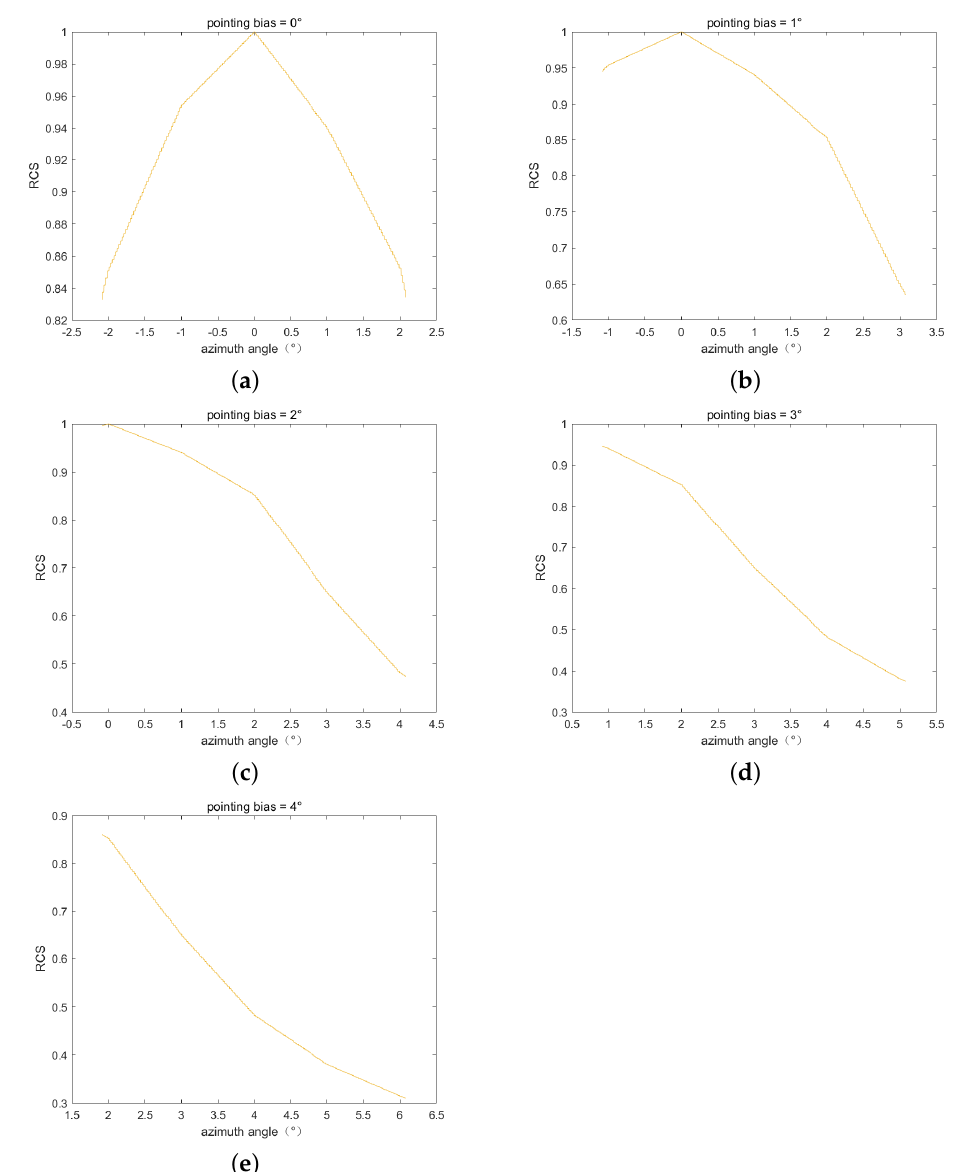
Figure 7. The normalized RCS pattern with different pointing deviations in the case of alignment. ( a ) Pointing deviation = 0 ◦ ; ( b ) pointing deviation = 1 ◦ ; ( c ) pointing deviation = 2 ◦ ; ( d ) pointing deviation = 3 ◦ ; ( e ) pointing deviation = 4 ◦